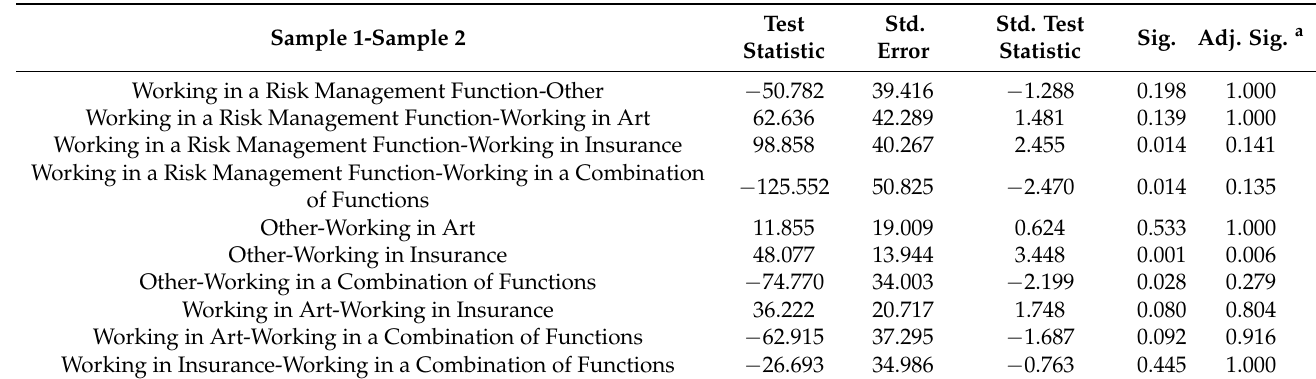
Table 18. Post hoc analysis—availability of